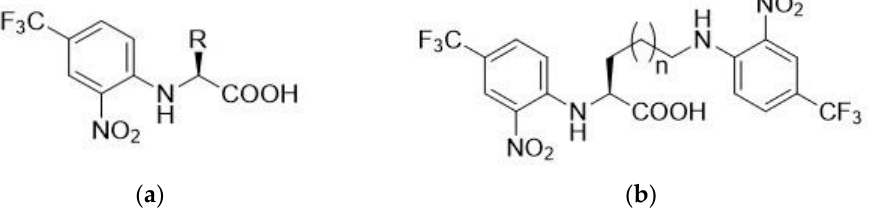
Figure 1. Chemical structures of amino acids derivatives with FNBT; ( a ) (2-Nitro-4-(trifluoromethyl)phenyl)- L -amino acid; ( b ) N 2 ,N 6(5) -Bis(2-nitro-4-(trifluoromethyl)phenyl)- L -amino acid.